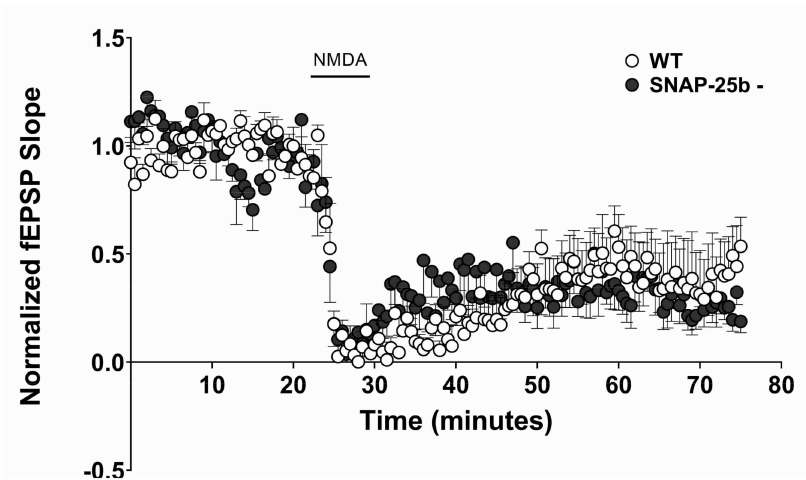
Figure 8. Di ff erences observed in synaptic plasticity in one month old SNAP-25b-deficient mice of both sexes were not due to alterations in NMDAR response to glutamate. The presence of SNAP-25a in mutant mice (filled circles, n = 5) did not alter the extracellular amplitude of NMDA-induced cLTD (20 µ M; solid bar = 5 mins at 2mL / min) compared to WT littermates (open circles, n = 7) at Scha ff er collateral-CA1 synapses. Each point is normalized to averaged baseline and is mean ± SEM of n